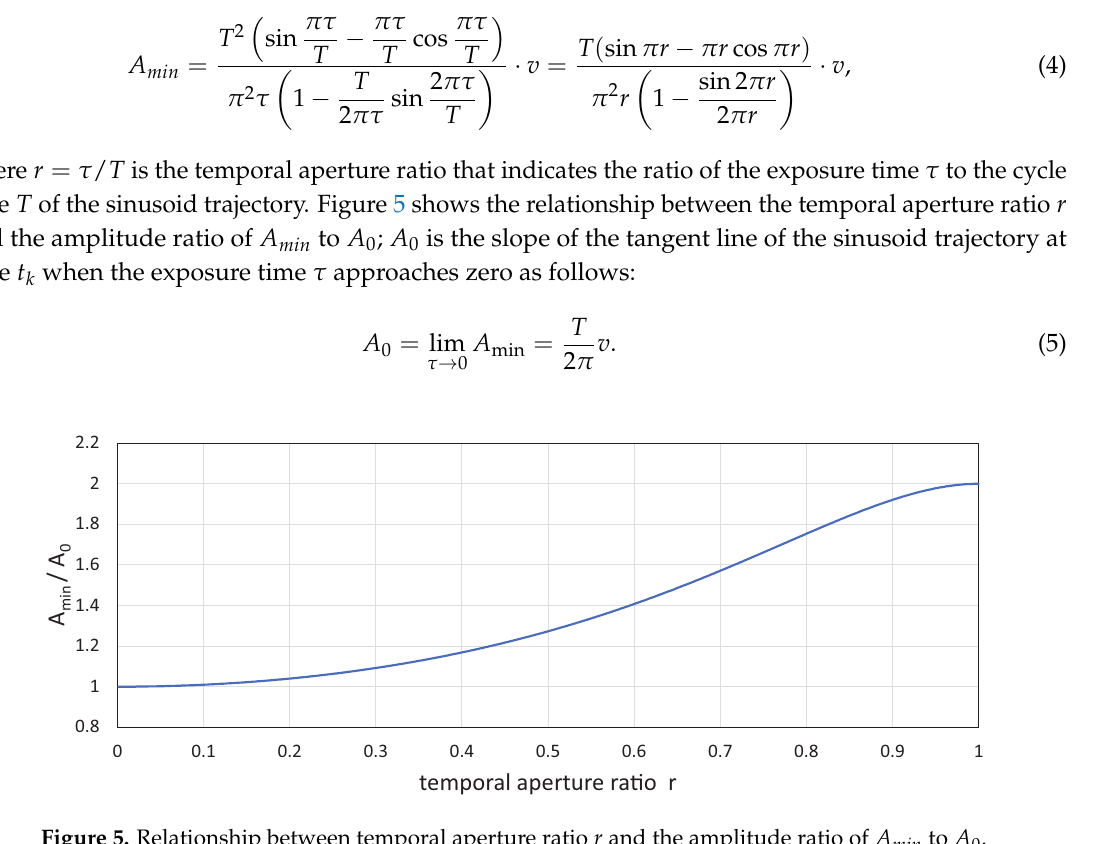
Figure 5. Relationship between temporal aperture ratio r and the amplitude ratio of A min to A 0